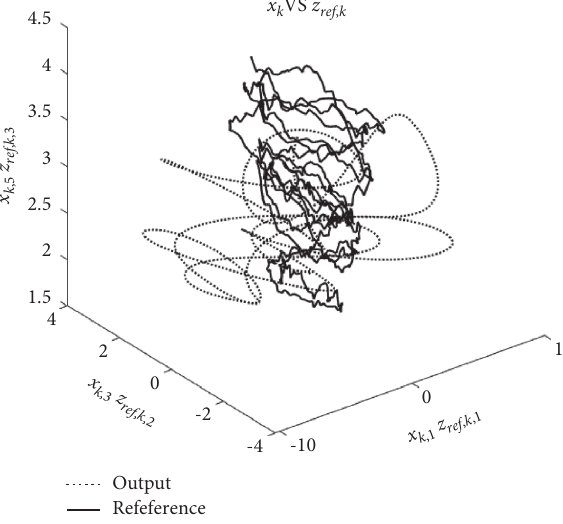
Figure 13: Behavior of the quadrotor when random references are tracking.